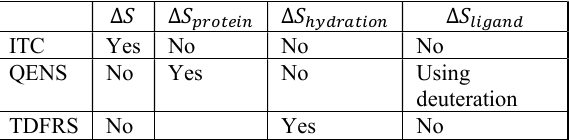
Table 1 This table provides an overview about the methods which are appropriate for which entropy